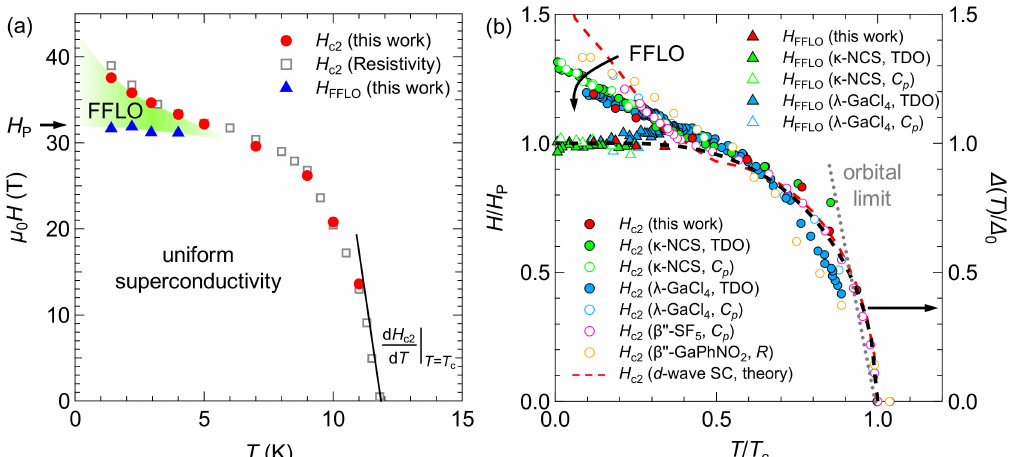
Figure 5. ( a ) H - T superconducting phase diagram of κ -Br in parallel fields. The gray boxes are the reported H c2 data [21]. The solid line indicates the slope of the H c2 curve near T c at 0 T. The light green region above H P is the FFLO state. ( b ) Superconducting phase diagram scaled by H P and T c , H / H P vs. T / T c . The circles and triangles represent H c2 and H FFLO , respectively. The color of the symbols denotes the material. The filled symbols are taken from the TDO measurements [23,26,27], whereas the unfilled symbols are from other measurements [25,39,44,45]. The dotted gray line represents an example of the temperature dependence of H orb , which is higher than H c2 at low temperatures. The red dotted curve is a simple theoretical calculation [9] of H c2 for the FFLO state with d-wave superconducting symmetry. The black dashed curve (right axis) is the temperature dependence of the reduced BCS-type superconducting gap ∆ ( T )/ ∆ 0